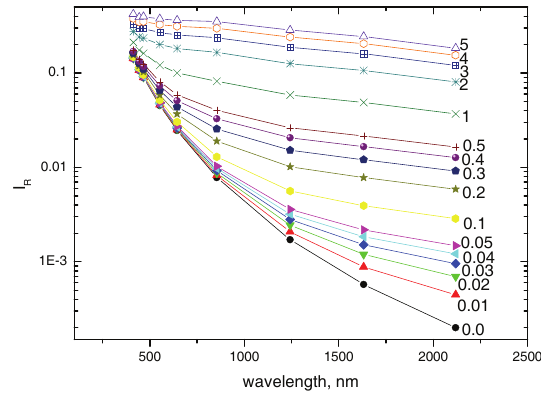
Fig. 8. Spectral reflectance presented for various values of AOT (412nm) at the nadir observation and the SZA equal to 60 ◦